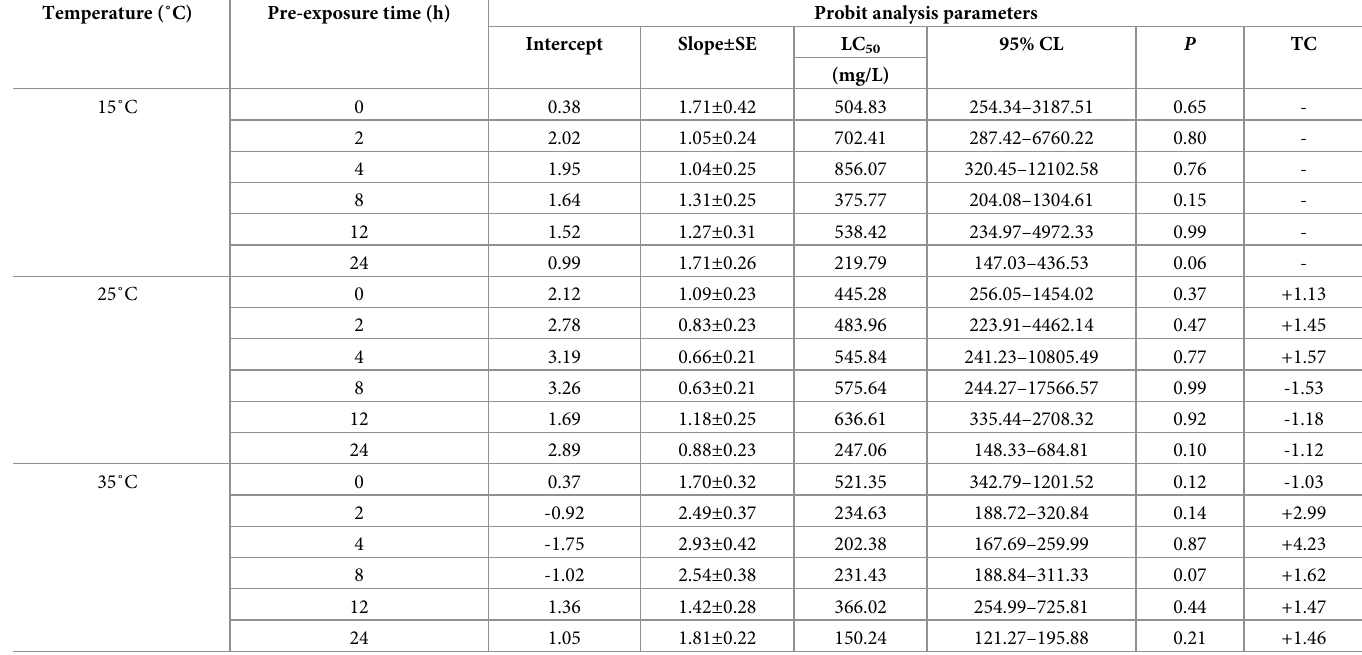
Table 3. Influence of pre-exposure time on the toxicity of non-effect temperature effect insecticide phoxim to A . lucorum at 15, 25, 35˚C. Temperature